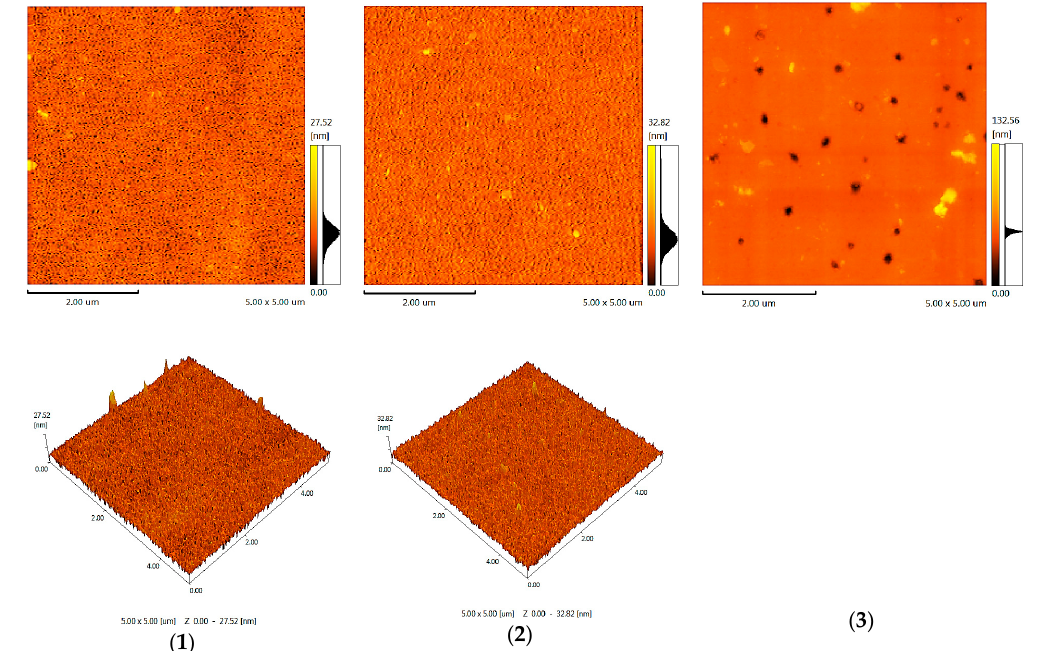
Figure 8. Atomic force microscopy of polymers. The content of POE blocks (wt %) is 15 ( 1 ); 20 ( 2 ); and 30 ( 3 ).